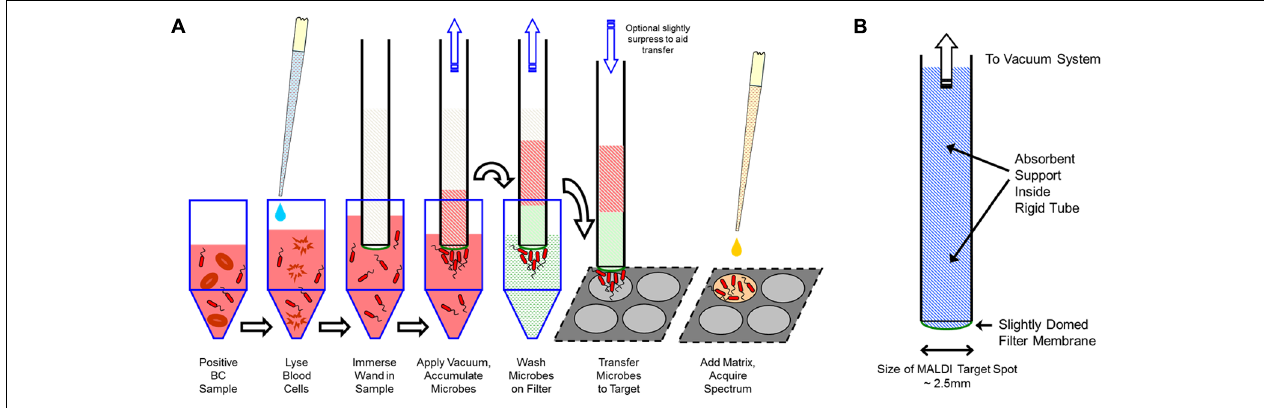
FIGURE 1 | (A) Filter wand extraction and spotting concepts. (B) Filter wand schematic description (from bioMérieux patent W02013/016211).